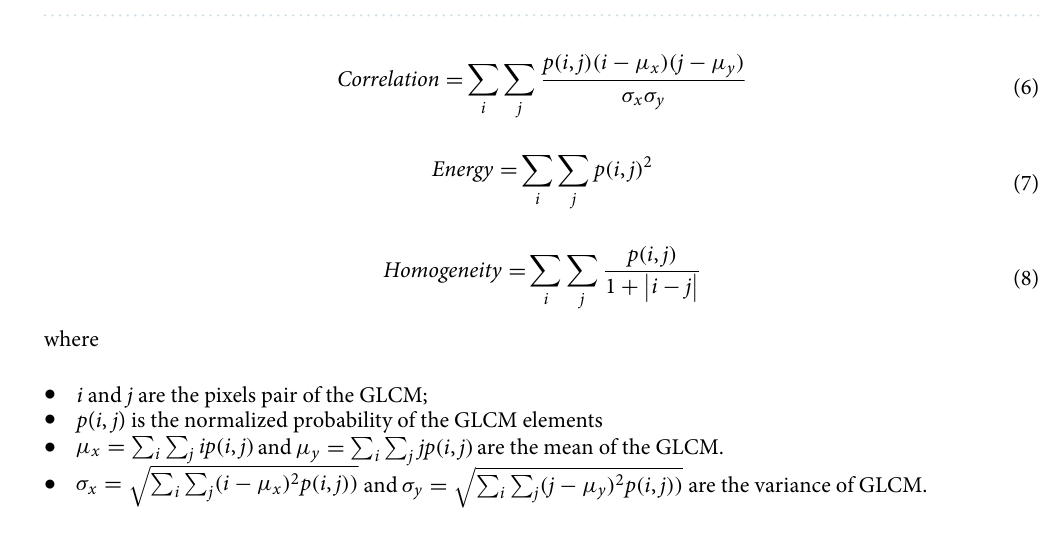
Figure 8. An illustrative color-coded example of GLCM features for a normal (upper row) and a DR (lower row) case at three different layers: ( a ) NFL, ( b ) ONL, and ( c ) RPE